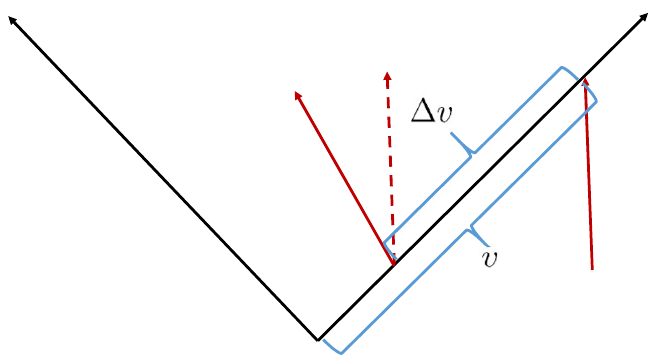
Figure 1 . A massive particle attempts to enter the horizon at some v > 0 and u = 0. The shock wave at the edge of the IFS at u = 0 pushes the particle to v + (cid:1) v . The particle is also boosted by the shock wave, and it thus follows the solid line and not the dashed line. When (1) is satis(cid:12)ed, (cid:1) v = (cid:0) v , the boost factor is in(cid:12)nite, and the particle follows the v = 0 trajectory | it does not fall into the black